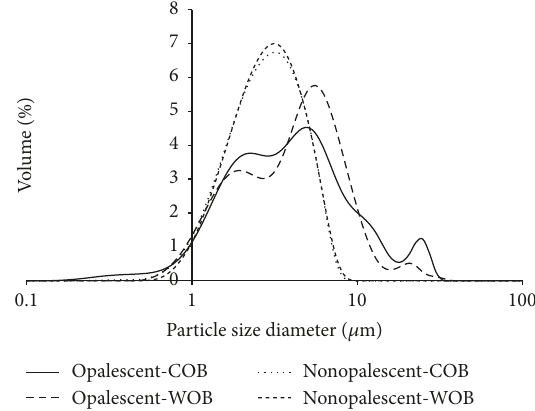
Figure 11: Particle size distributions of crude oil body (COBs) and washed oil body (WOBs) emulsions of opalescent and nonopales- cent pecan